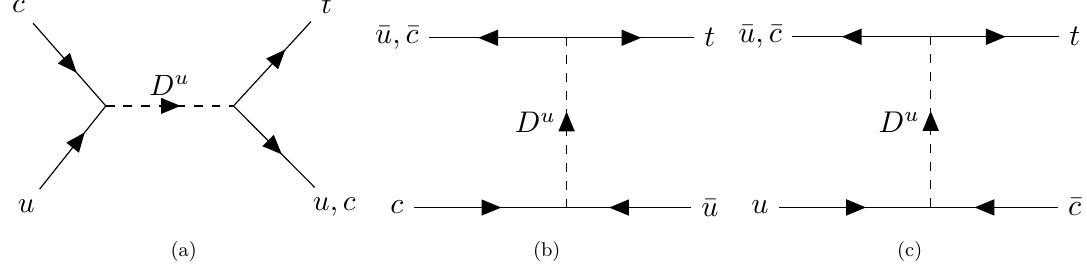
Figure 5 . Diquark contributions to single-top production in the t channel in p p